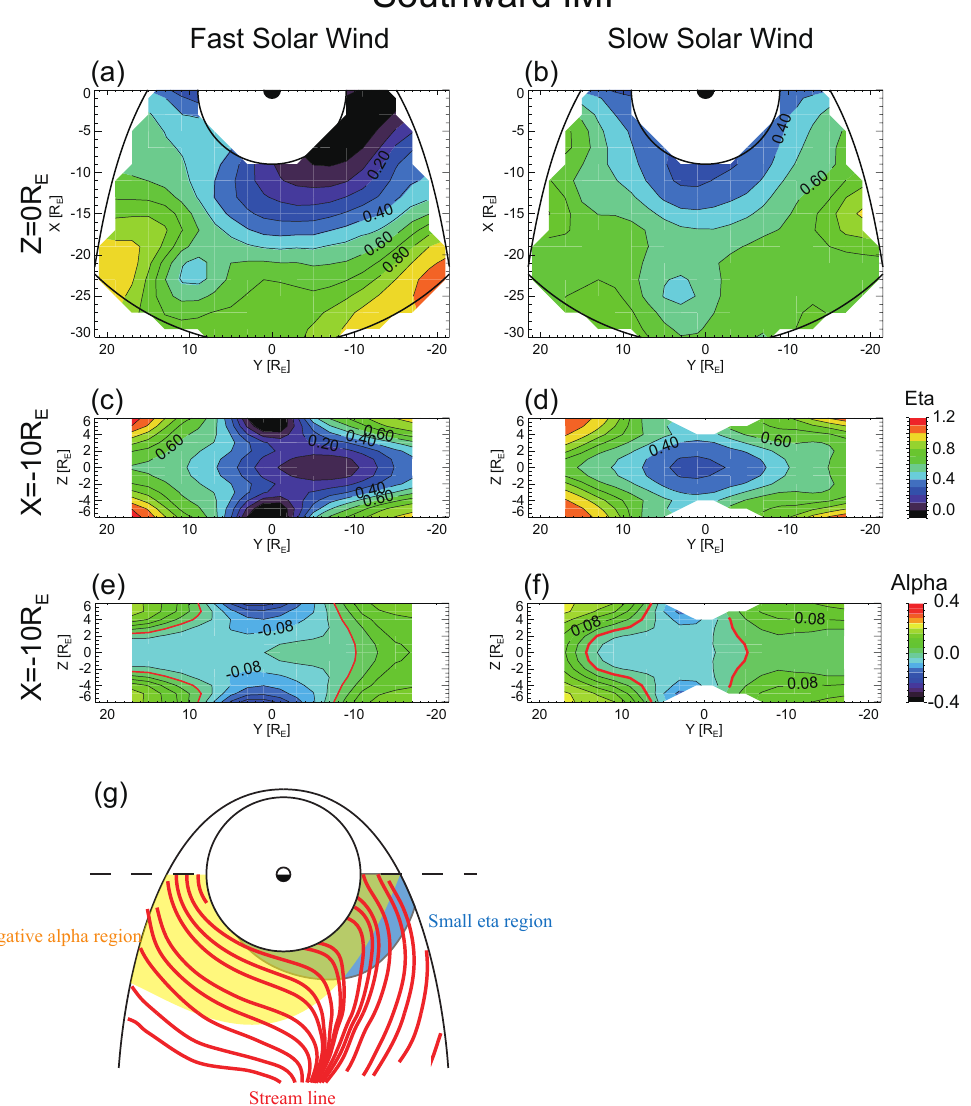
Fig. 12. (a–d) solar wind number density dependence under southward IMF condition for fast and slow solar wind conditions. (e–f) IMF B z dependence at X = − 10 R E for fast and slow solar wind conditions. (g) Schematic picture of plasma transport in the near-Earth plasma